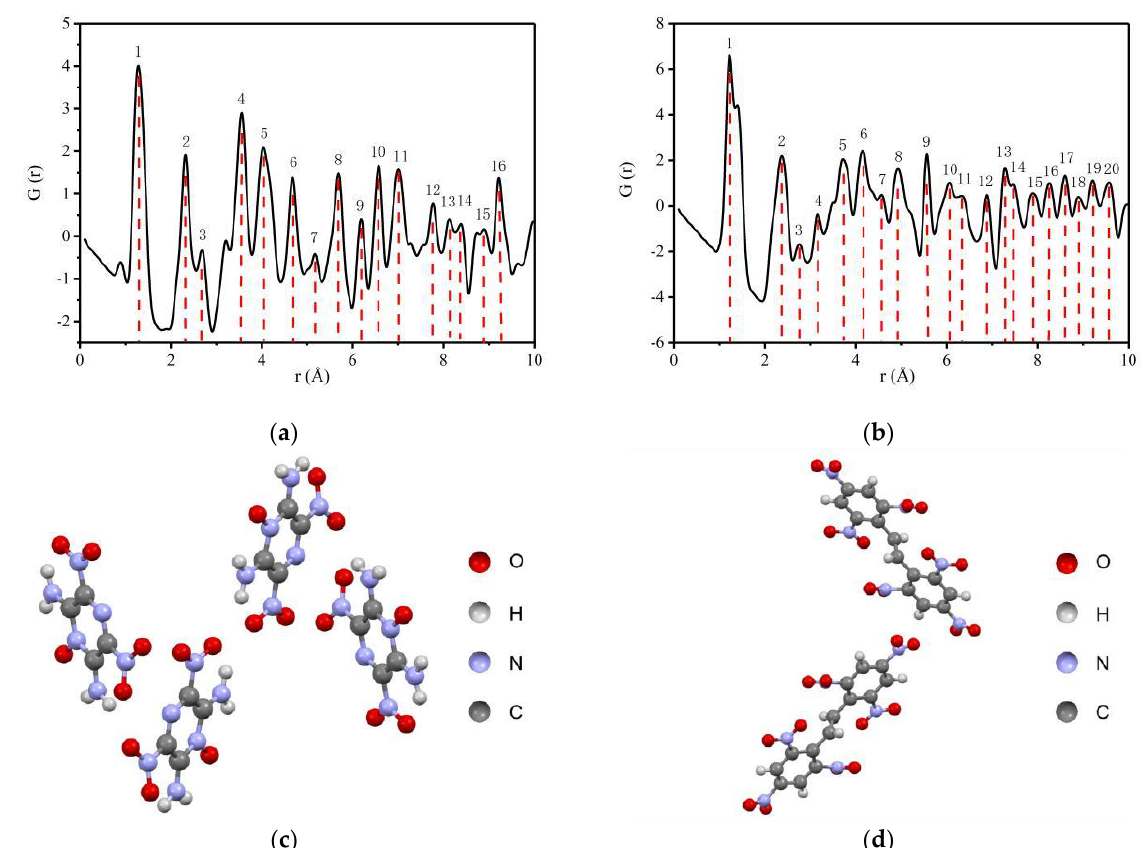
Figure 2. PDF curves of LLM-105 and HNS calculated by crystal structures: ( a ) PDF of LLM-105; ( b ) PDF of HNS; ( c ) Crystal structure of LLM-105; ( d ) Crystal structure of HNS.